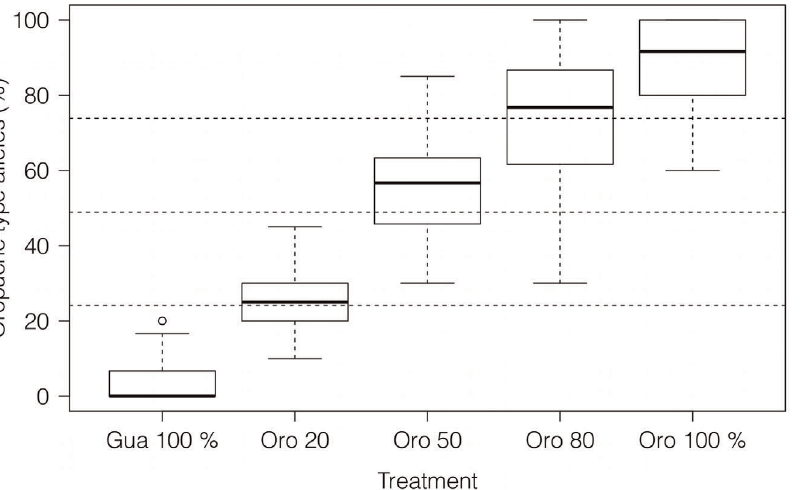
Figure 4. Percentage of SNPs from the mesocosm experiment. The percentage of Oropuche nucleotides scored at 14 SNPs across different four loci that distinguished between Guanapo and Oropuche origin for all treatments. Dashed lines at 20, 50 and 80% indicate where a theoretical mean for each treatment would be expected given that only the proportion of introduced fish is important for the distribution of Guanapo and Oropuche allele frequencies. Medians, interquartile ranges and outliers are shown.